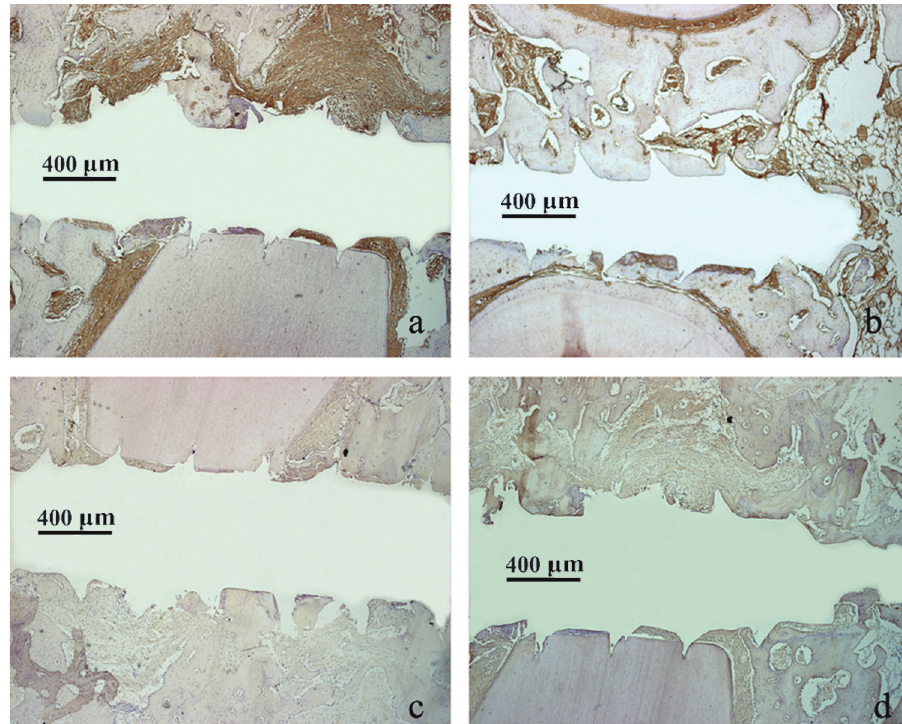
Figure 9- Immunohistochemical staining of TNF-α in beagle mandible sections from test (a and c) and control group (b and d), during weeks 3 and 8. Statistically significant differences were observed between the two groups at week 3. The TNF-α values in test group (a) were higher than in control group (b). The expression in test group (c) and control group